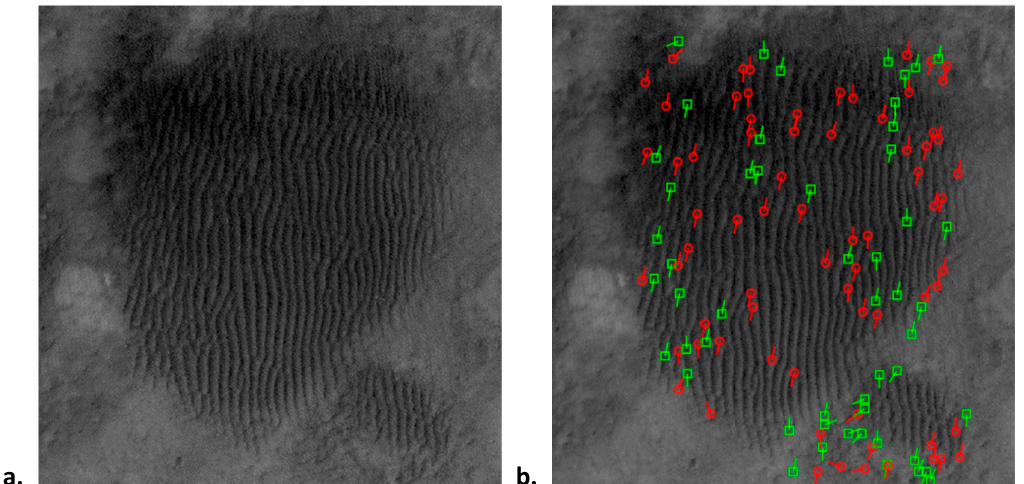
Figure 11. Meridini Plain MER Spirit landing and exploration site. Four TAR test sites indicated.